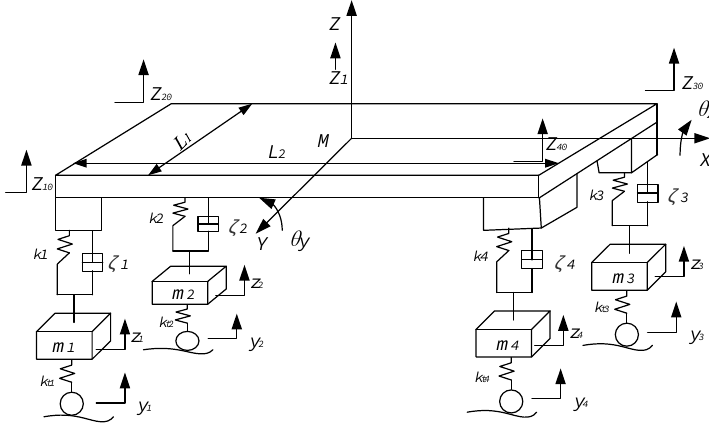
Figure 8. The dynamic model of the vehicle.